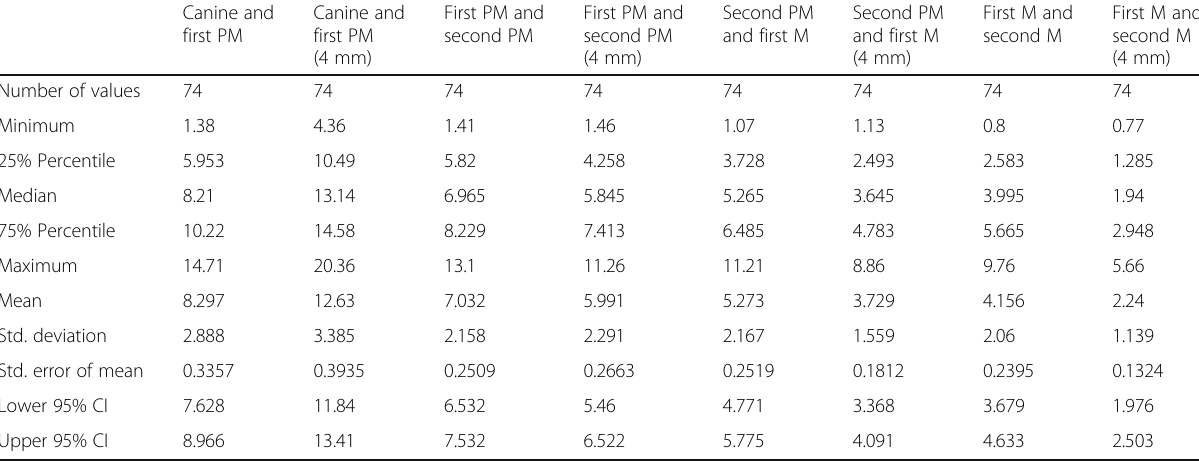
Table 3 Descriptive statistics of palatal bone thickness in non-growing male